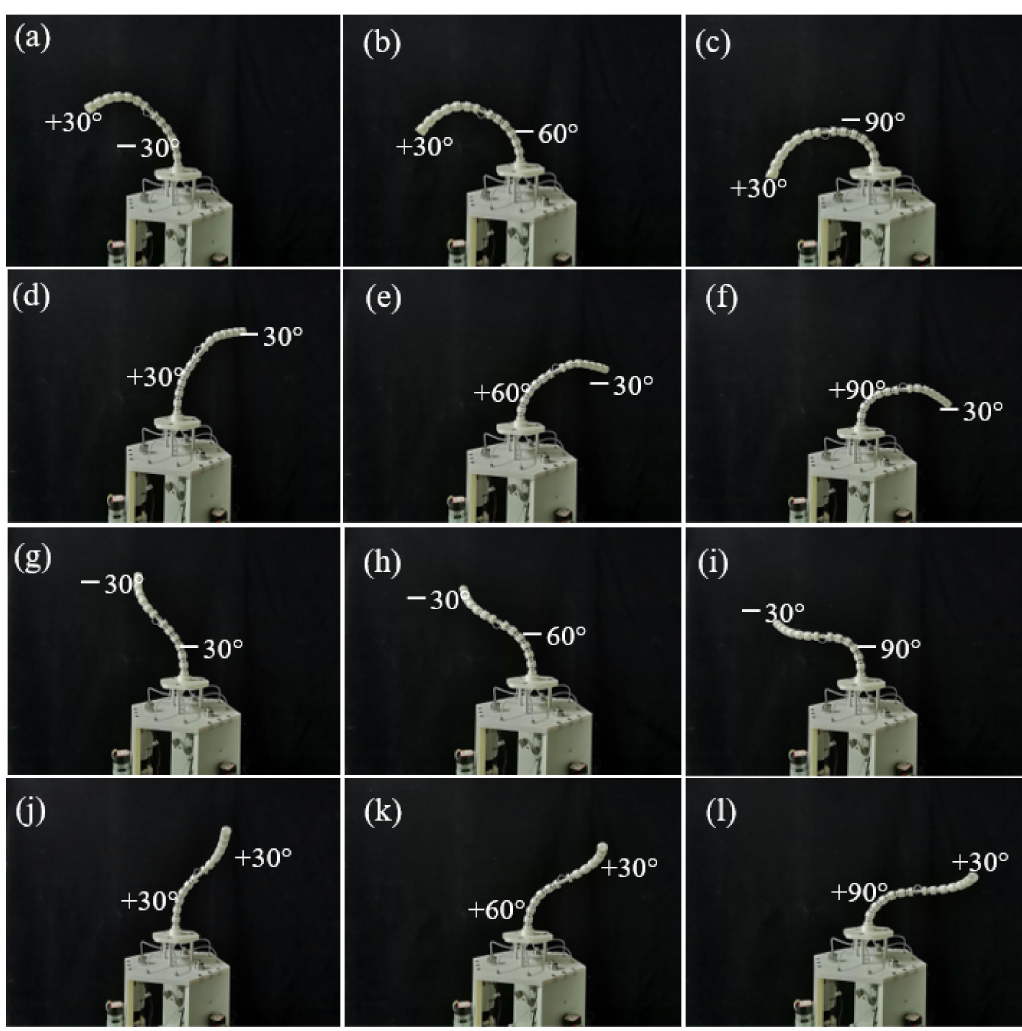
Figure 23. Multi-DOF bending motion test of a cable-driven snake-arm robot. ( a ) The configuration with the bending angle − 30 ◦ of the proximal segment and the bending angle +30 ◦ of the distal segment. ( b ) The configuration with the bending angle − 60 ◦ of the proximal segment and the bending angle +30 ◦ of the distal segment. ( c ) The configuration with the bending angle − 90 ◦ of the proximal segment and the bending angle +30 ◦ of the distal segment. ( d ) The configuration with the bending angle +30 ◦ of the proximal segment and the bending angle − 30 ◦ of the distal segment. ( e ) The configuration with the bending angle +60 ◦ of the proximal segment and the bending angle − 30 ◦ of the distal segment. ( f ) The configuration with the bending angle +90 ◦ of the proximal segment and the bending angle − 30 ◦ of the distal segment. ( g ) The configuration with the bending angle − 30 ◦ of the proximal segment and the bending angle − 30 ◦ of the distal segment. ( h ) The configuration with the bending angle − 60 ◦ of the proximal segment and the bending angle − 30 ◦ of the distal segment. ( i ) The configuration with the bending angle − 90 ◦ of the proximal segment and the bending angle − 30 ◦ of the distal segment. ( j ) The configuration with the bending angle +30 ◦ of the proximal segment and the bending angle +30 ◦ of the distal segment. ( k ) The configuration with the bending angle +60 ◦ of the proximal segment and the bending angle +30 ◦ of the distal segment. ( l ) The configuration with the bending angle +90 ◦ of the proximal segment and the bending angle +30 ◦ of the distal